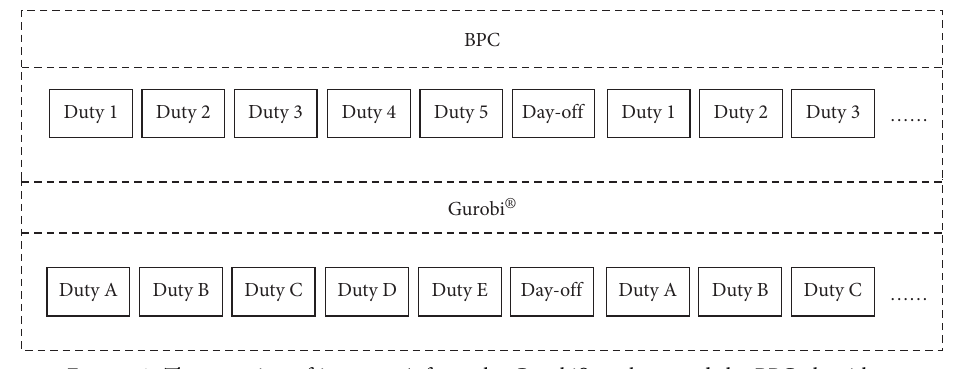
Figure 9: The rostering of instance A from the Gurobi ® package and the BPC algorithm.